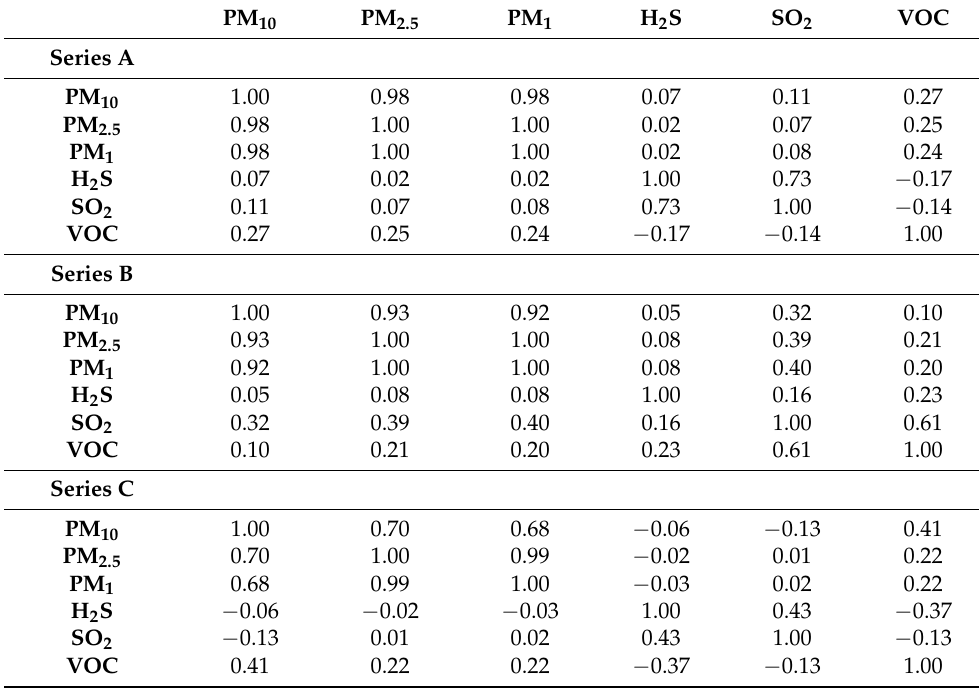
Table 5. Correlation coefficient between measurement parameters from the intersection area for three measurement